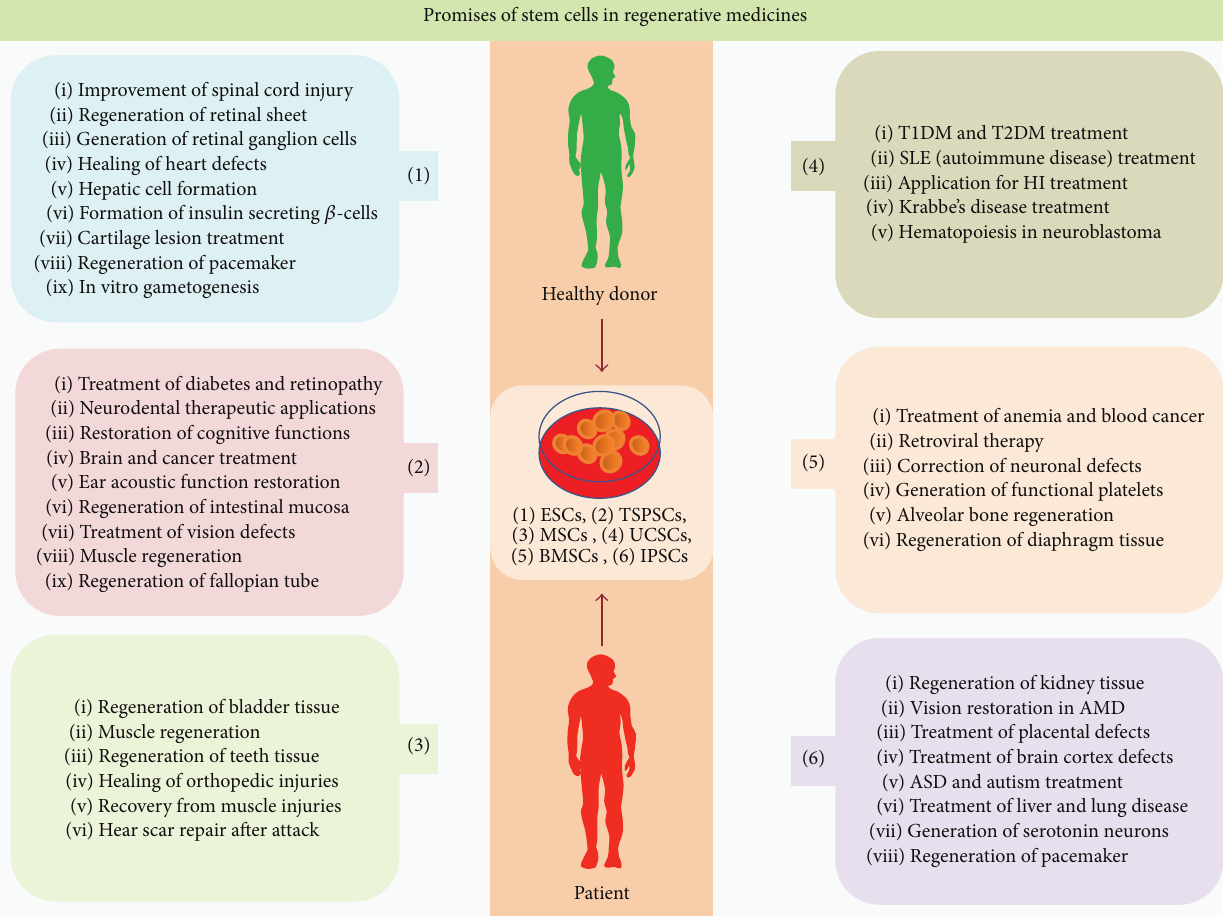
Figure 1: Promises of stem cells in regenerative medicine: the six classes of stem cells, that is, embryonic stem cells (ESCs), tissue specific progenitor stem cells (TSPSCs), mesenchymal stem cells (MSCs), umbilical cord stem cells (UCSCs), bone marrow stem cells (BMSCs), and induced pluripotent stem cells (iPSCs), have many promises in regenerative medicine and disease therapeutics.